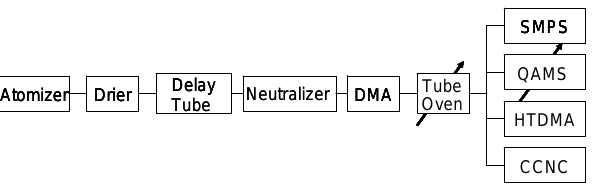
Fig. 1. Schematics of experimental set up (details see Figure 1. Schematics of experimental set up. (Details see text.)